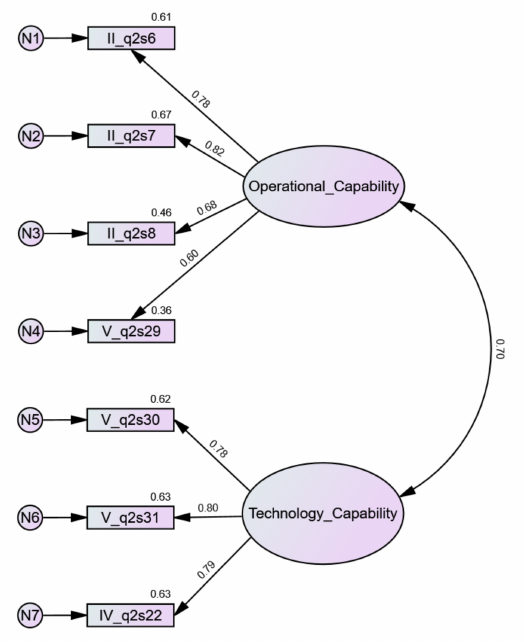
Figure 7. CFA model of organizational e-readiness (standardized